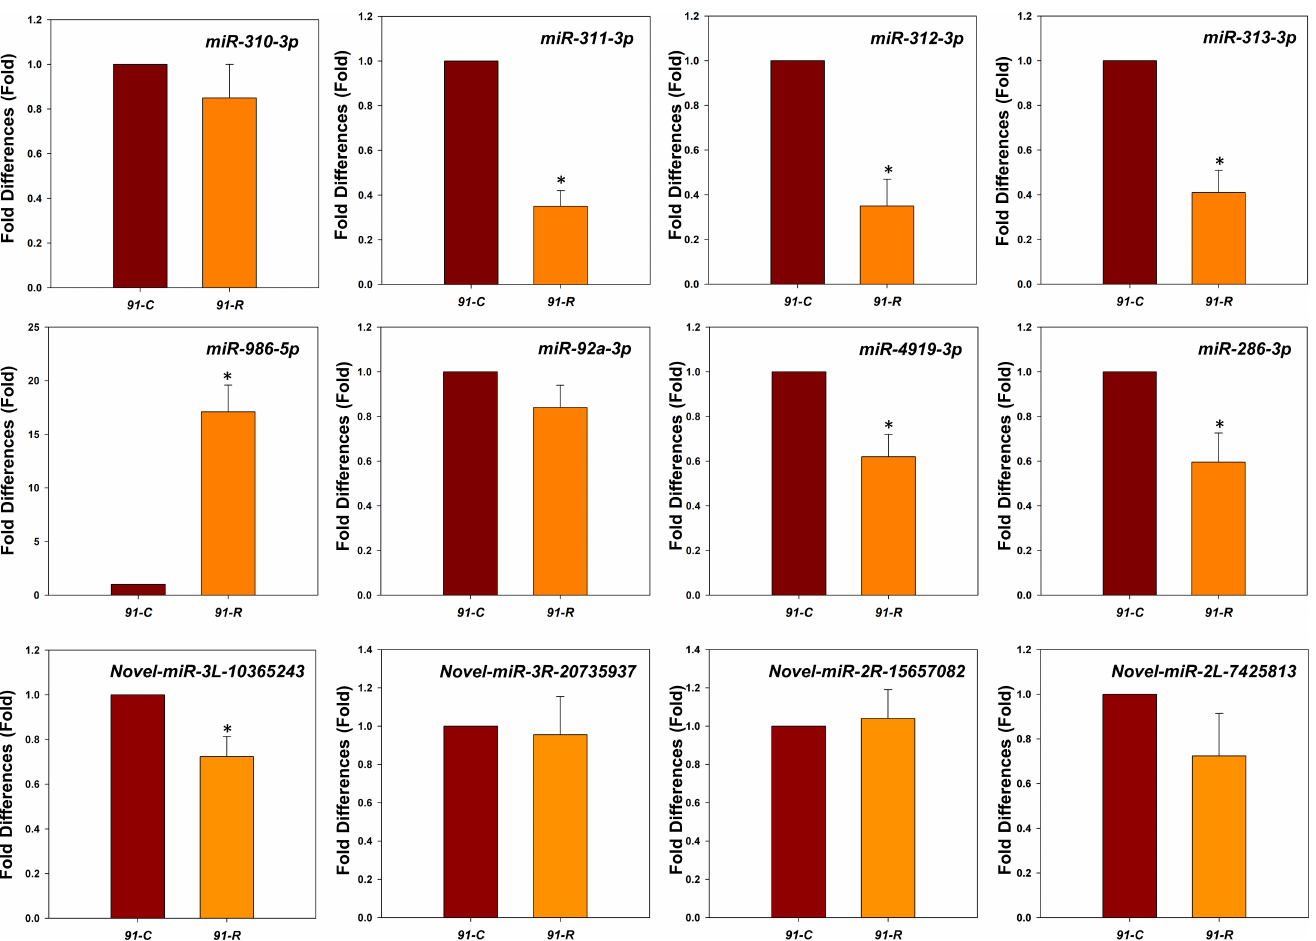
Fig 1. RT-qPCR validation of differentially expressed known and novel miRNAs identified between 91-R and 91-C strains. The expression levels were normalized by both U6 and 5S rRNA . Statistical significance was analyzed using one-way ANOVA. The asterisks represent significance, where one asterisk indicates P <